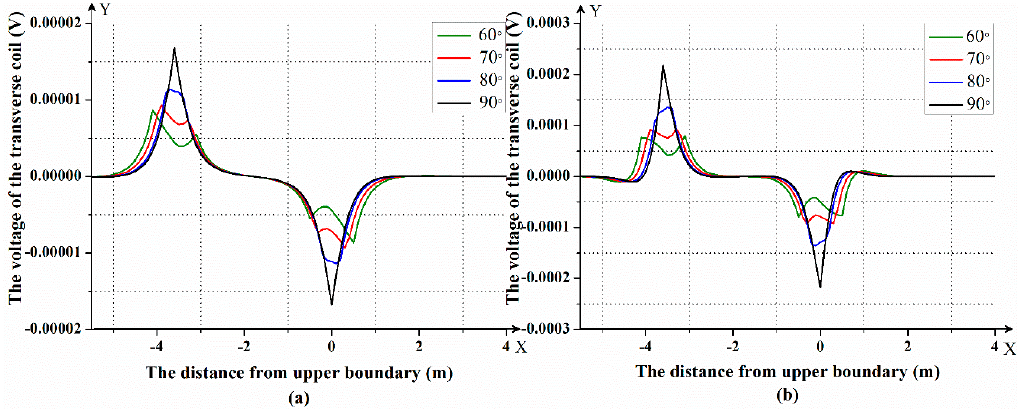
Figure 5. The voltage of the transverse receiving coil Re 3 at a frequency of (a) 400 KHz and (b) 2 MHz.